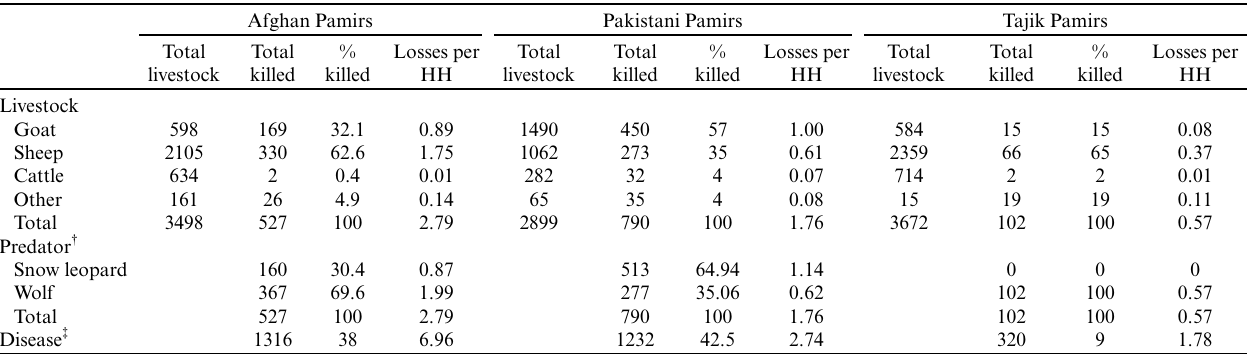
Table 2 . Livestock losses due to predators and diseases in the Pamirs during the period January 2008–June 2012.